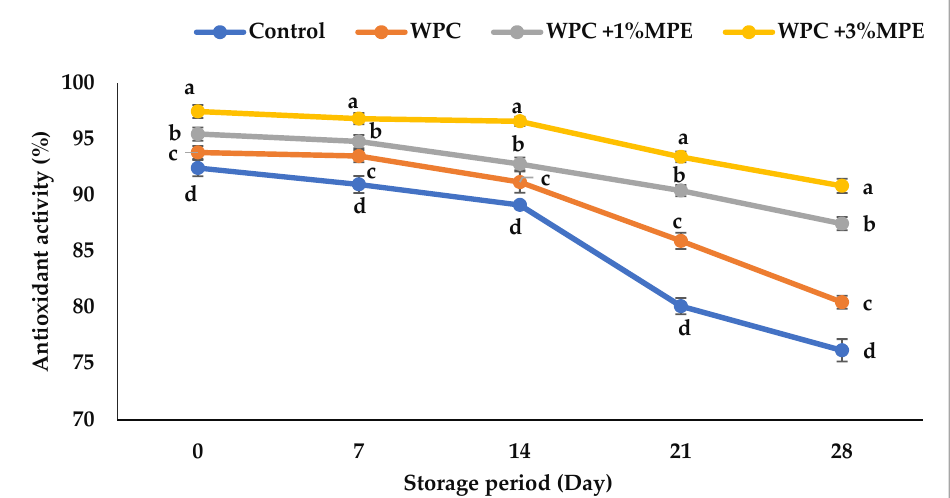
Figure 7. Effect of whey protein concentrate combined with mango peel extract (WPC = whey protein concentrate alone, WPC + 1% MPE = whey protein concentrate + mango peel extract at 1% and WPC + 3% MPE = whey protein concentrate + mango peel extract at 3%) on antioxidant activity of broccoli fresh-cuts at 5 ◦ C. Vertical bars indicate standard deviation (n = 6). Means and different letters indicate significant difference between treated and control broccoli for each storage period (Duncan’s multiple range test at